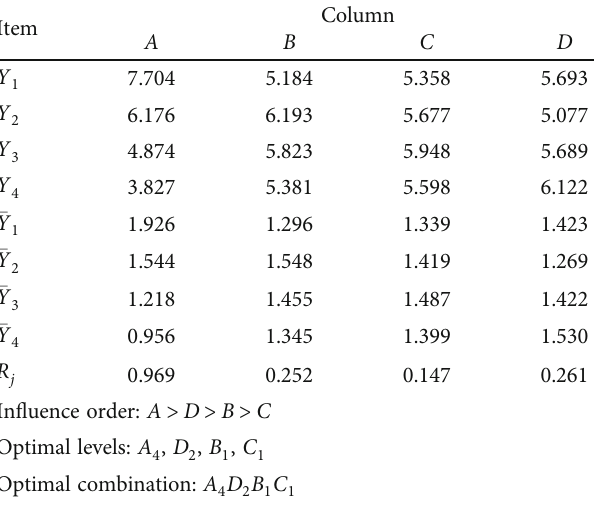
Table 7: Analysis of variance.